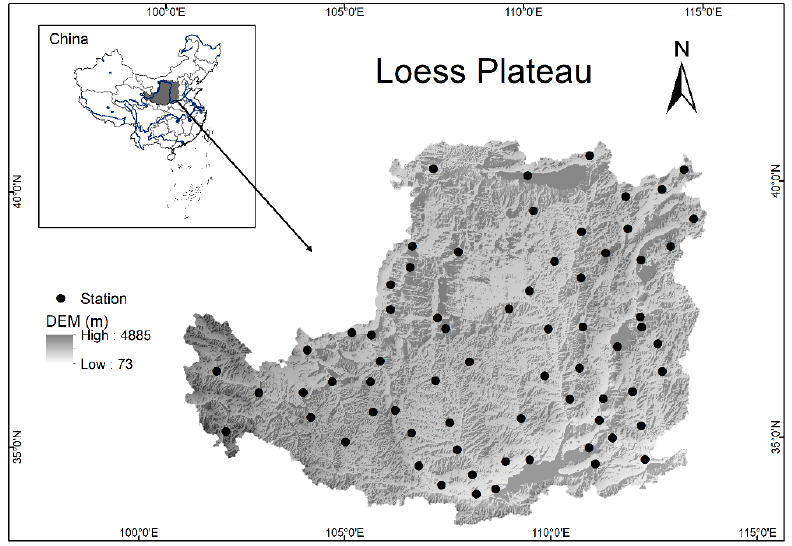
Figure 1. Geographical location and 69 meteorological stations of the Loess Plateau.